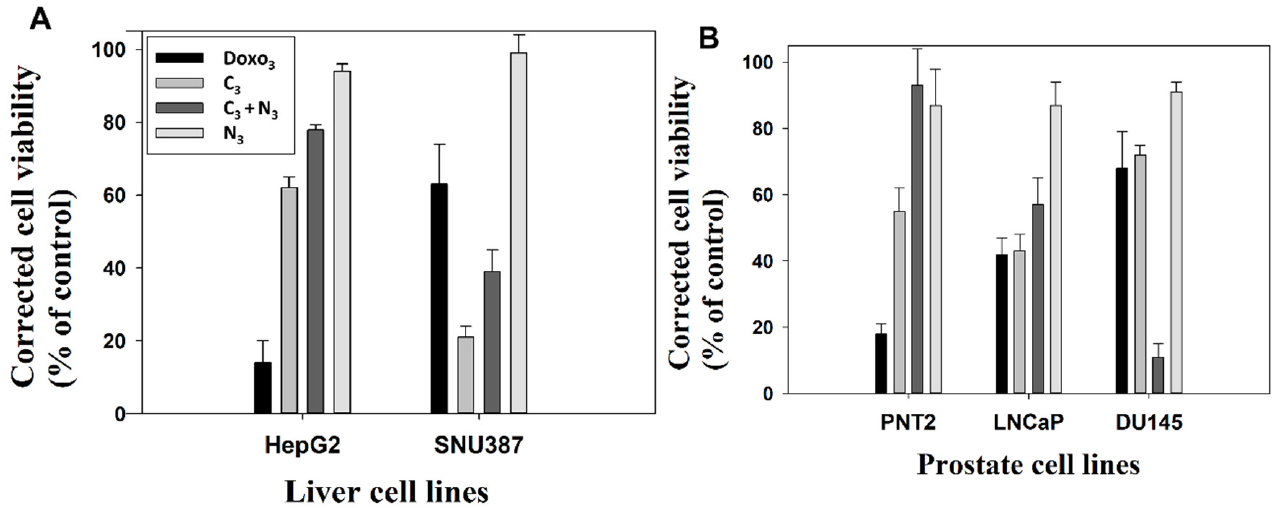
Figure 6. Corrected cell viability of treated cells versus control at 48 h after treatment with Doxo 3 , C 3 , C 3 +N 3 and N 3 formulations. Viability of the control corresponds to 100%. ( A ) HepG2 and SNU387 liver cell lines. ( B ) PNT2, LNCap and DU145 cell lines.